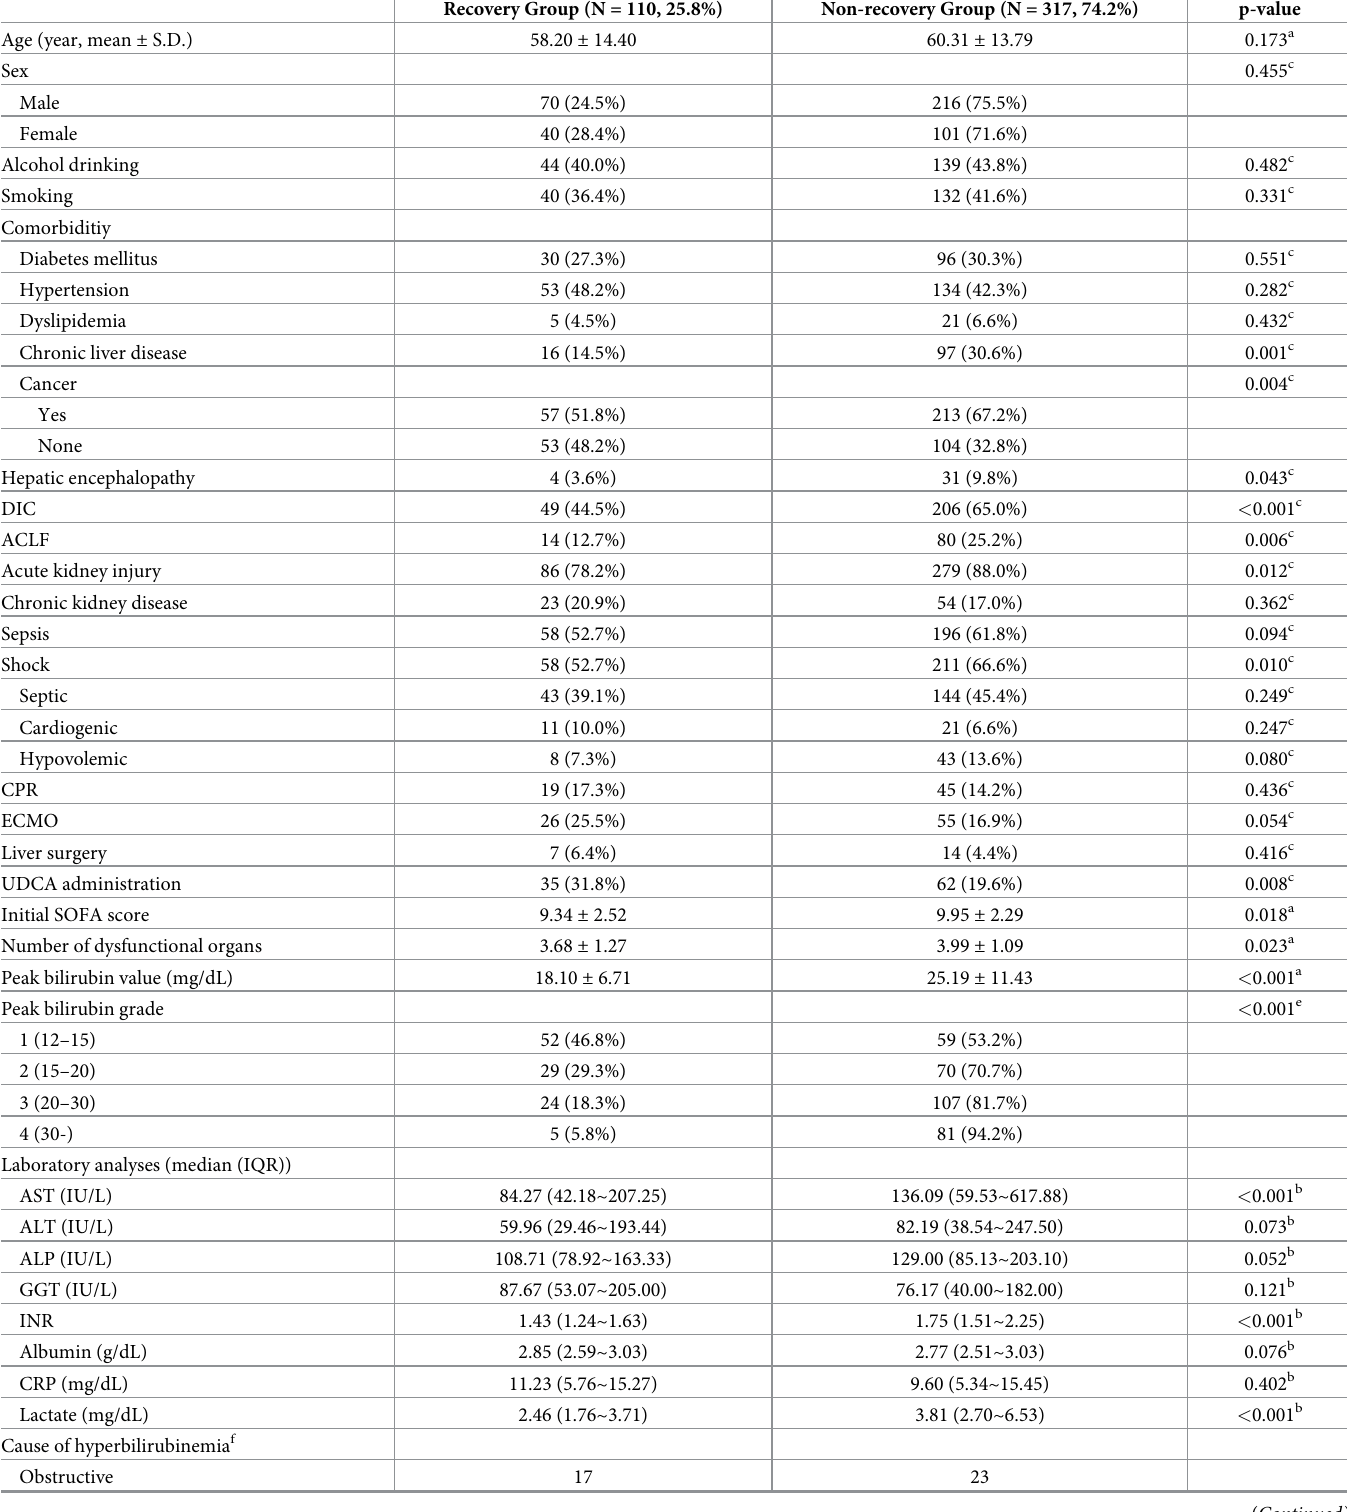
Table 4. Comparison of patient characteristics between recovery and non-recovery